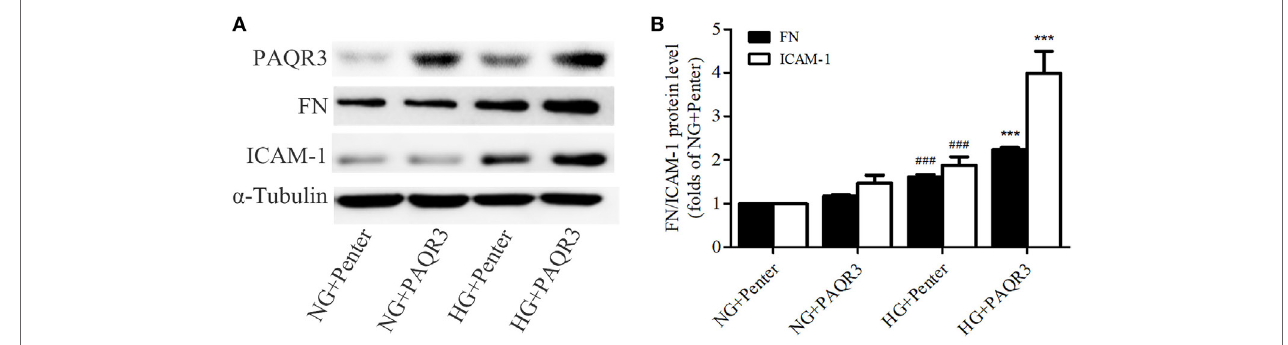
FigUre 2 | Overexpression of progestin and adipoQ receptor 3 (PAQR3) induced the expressions of fibronectin (FN), intercellular adhesion molecule-1 (ICAM-1) in high glucose (HG)-cultured glomerular mesangial cells (GMCs). GMCs were transfected with 2 µg of Penter vector or his-PAQR3, respectively. After treatment with HG for 24 h, total proteins were extracted to measure expressions of PAQR3, FN, and ICAM-1 (a,B) . ### P < 0.001 vs. NG + Penter, *** P < 0.001 vs. HG + Penter. Independent experiments were performed at least three times with similar results.